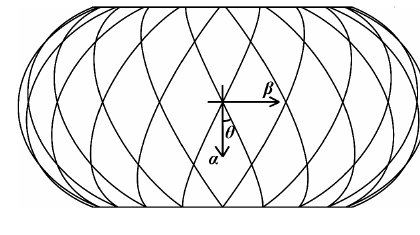
Figure 4: The winding angle of the reinforced